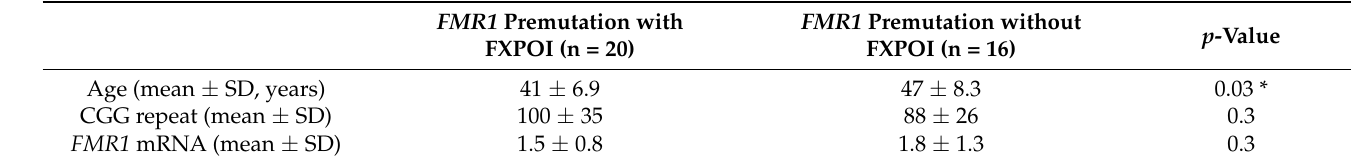
Table 1. Clinical and molecular characteristics of individuals recruited in the study. FMR1 Premutation with FMR1 Premutation without p -Value FXPOI (n = 20) FXPOI (n = 16) Age (mean ± SD, years) 41 ± 6.9 47 ± 8.3 0.03 * CGG repeat (mean ± SD) 100 ± 35 88 ± 26 0.3 FMR1 mRNA (mean ± SD) 1.5 ± 0.8 1.8 ± 1.3